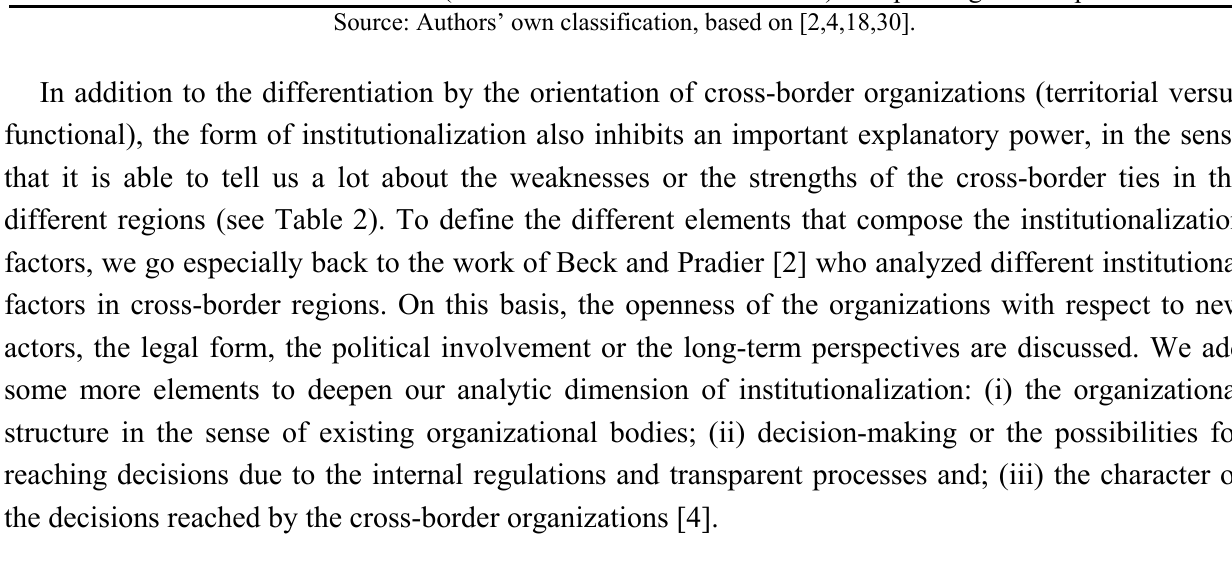
Table 2. Strong versus weak